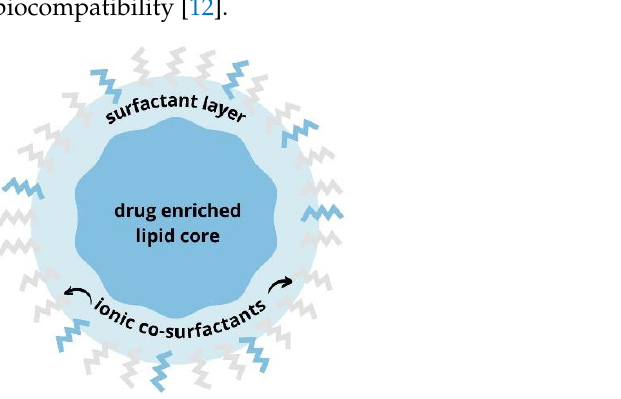
Figure 2. The structure of solid lipid nanoparticle. SLNs have lipid core with an incorporated lipid compound of interest and a surfactant layer on the surface which enables solubility in hydrophilic solutions. Ionic co-surfactants provide electrical stability and prevent the possible aggregation of nanoparticles.